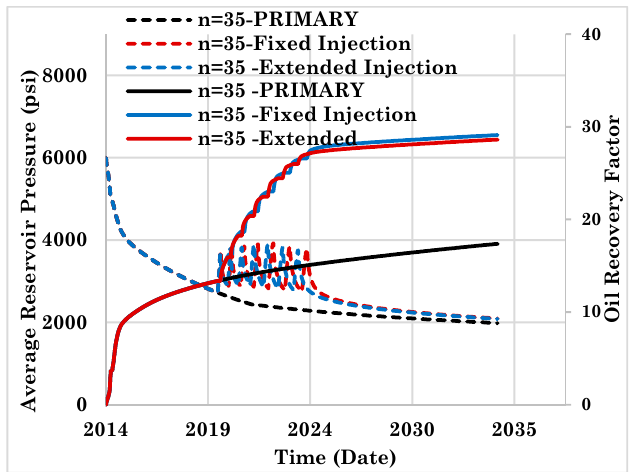
Figure 4. Dashed lines: average reservoir pressure; solid lines: oil recovery factor during CGI in both fixed and growing cycle sizes for n=35.